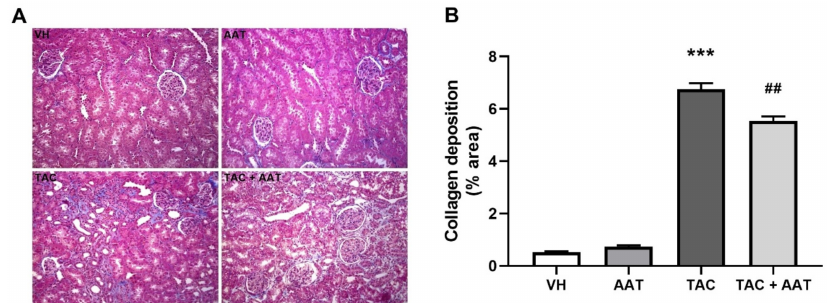
Figure 1. E ff ect of alpha-1 antitrypsin on collagen deposition in tacrolimus-induced renal injury. ( A ) Trichrome staining (200 × magnification). ( B ) Quantitative analysis of collagen deposition area. Data are presented as means ± standard errors; *** p < 0.001 vs. VH; ## p < 0.01 vs. TAC. Abbreviations: VH, vehicle group; AAT, alpha-1 antitrypsin treatment group; TAC, tacrolimus treatment group; TAC + AAT, tacrolimus and alpha-1 antitrypsin cotreatment group.